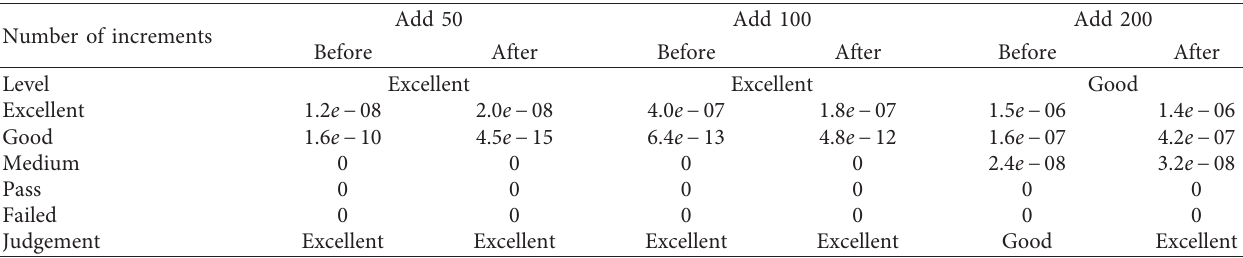
Table 5: Classification accuracy before and after increment.